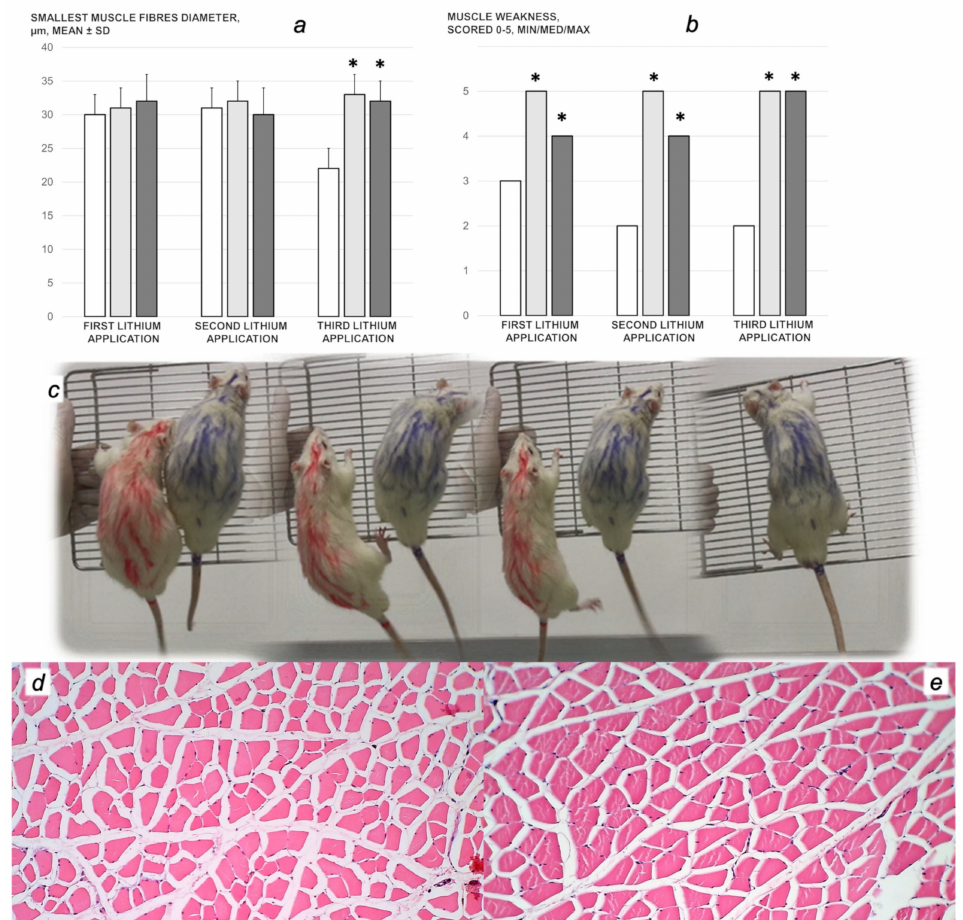
Figure 19. Muscle fiber diameter ( µ m, means ± SD) ( a ) and muscle weakness (scored 0–5, Min/Med/Max) ( b ) in the lithium- treated rats after the first, second, and third lithium administration (500 mg/kg/day intraperitoneally for 3 consecutive days). BPC 157 10 ng/kg (dark gray bars) or saline 5 mL/kg (white bars) given intraperitoneally after each of the three lithium administrations. Six rats/group/interval. * p < 0.05, at least vs. control. ( c ) Illustrative presentation of muscle weakness in rats after first lithium administration (red (control), blue (BPC 157)). Illustrative histology presentation of quadriceps muscle after third lithium administration, presentation with a smaller diameter of muscle fibers in control rats ( d ) and preserved muscle presentation in BPC 157-treated rats ( e ) (HE, × 100; scale bar 200 µ